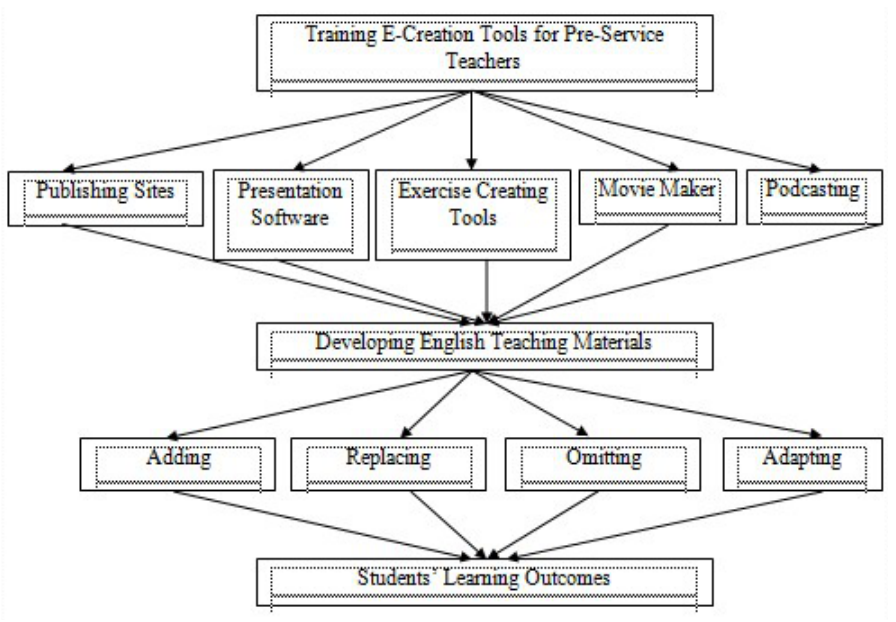
Figure 1: Theoretical